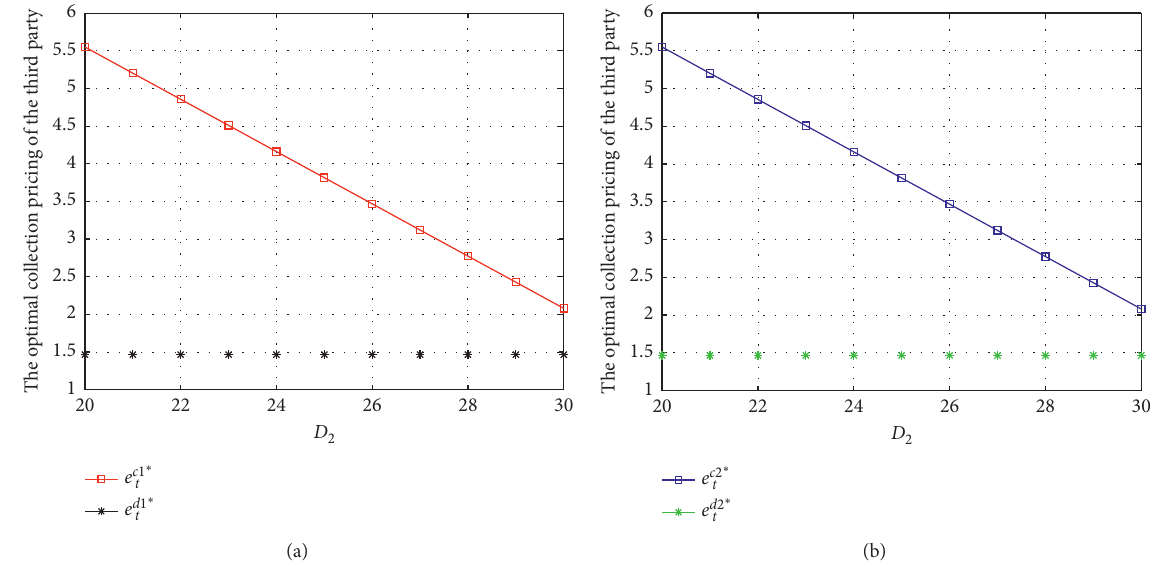
Figure 6: The optimal collection price of the third party under the centralized and decentralized model.